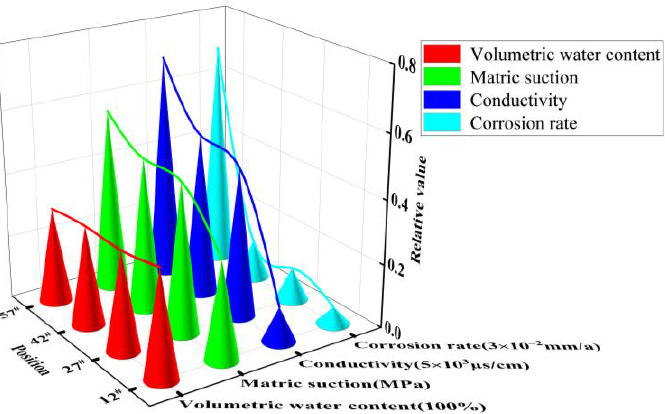
Figure 19. Variation trends of corrosion rate, soil volumetric water content, electrical conductivity, and matrix suction of X70 steel plate specimens aged 90 day at four height positions of 12 # , 27 # , 42 # , and 57 # with a soil column with NaCl content of 0.3%.